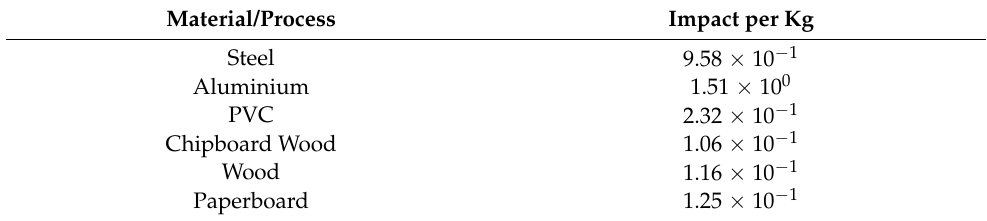
Table 5. Environmental impact of materials and processes for the case study.